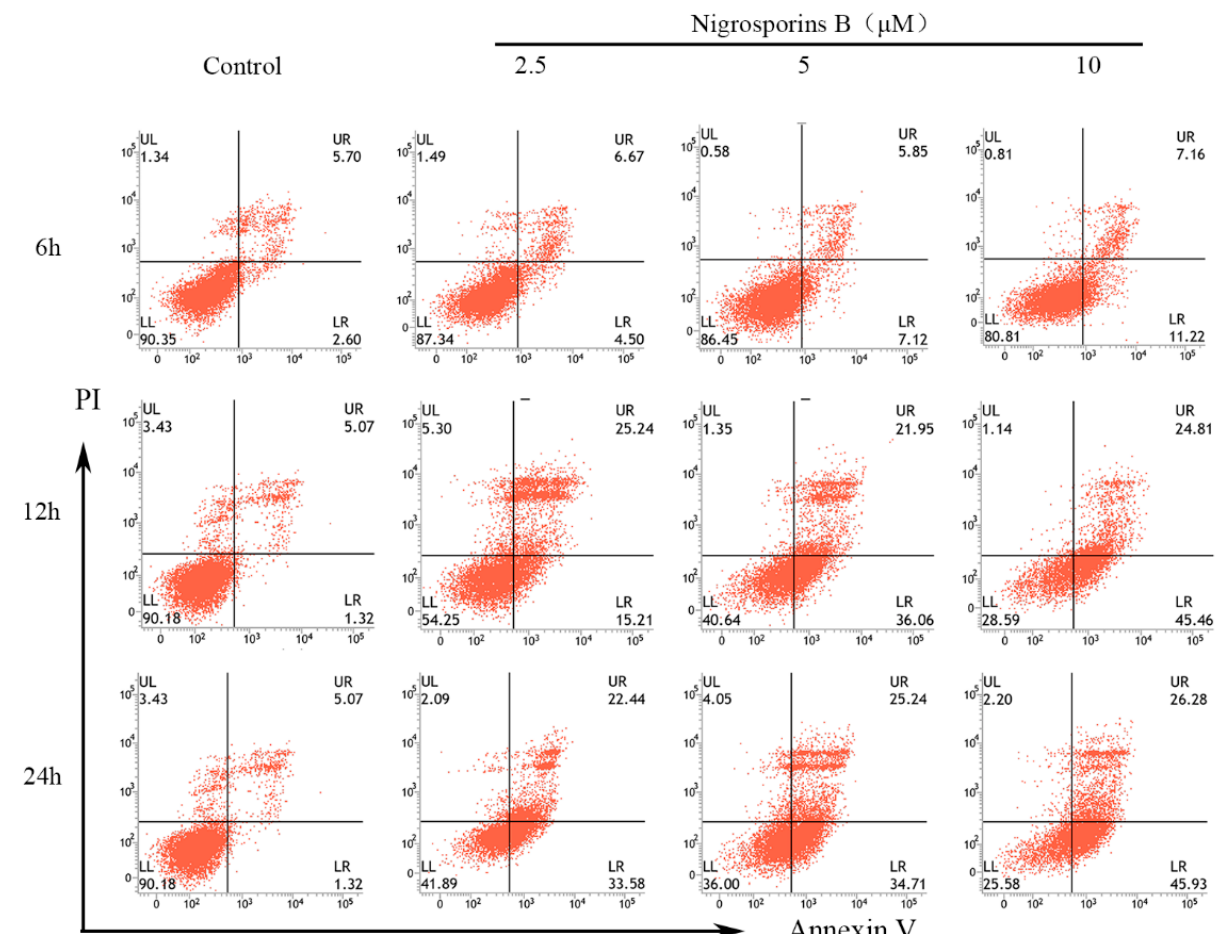
Figure 2. Nigrosporins B induces dose- and time-dependent apoptosis in Ca Ski cells, cells were treated with Nigrosporins B (0, 2.5, 5, 10 µ M) for 6 h, 12 h, 24 h, then detected by flow cytometry. The horizontal coordinate-axis X is the value of Annexin V, the longitudinal coordinate-axis Y is the value of PI. Annexin V − /PI − quadrant (LL) represents normal living cells, Annexin V − /PI + quadrant (UL) represents necrotic cells, Annexin V + /PI − quadrant (LR) represents early apoptotic cells, Annexin V + /PI + quadrant (UR) represents late apoptotic